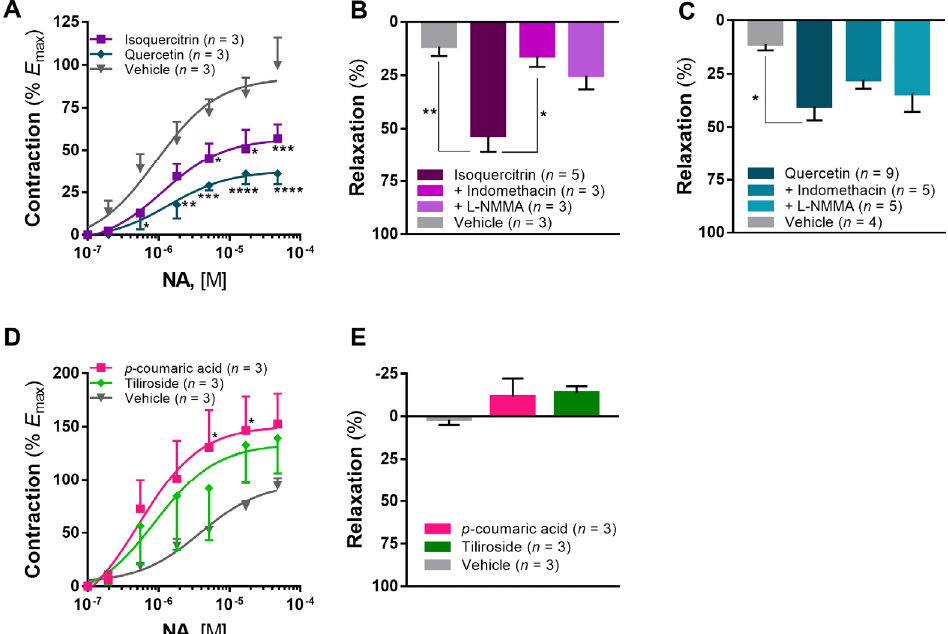
Figure 3. Vascular activity of isoquercitrin, quercetin, tiliroside and p -coumaric acid. ( A ) Effect of isoquercitrin and quercetin (28 μ g/mL) on the contraction induced by noradrenaline. Vasorelaxant effect on isoquercitrin ( B ) and quercetin ( C ) and influence of COX and endothelial nitric oxide synthase blocking with indomethacin (10 μ M) and L-NMMA (10 μ M), respectively. ( D ) Effect of p -coumaric acid (1.5 μ g/mL) and tiliroside (3 μ g/mL) on the noradrenaline-induced contraction. ( E ) Vasorelaxant effect of p -coumaric acid and tiliroside. * p < 0.05, ** p < 0.01, *** p < 0.001, **** p < 0.0001 vs. vehicle.